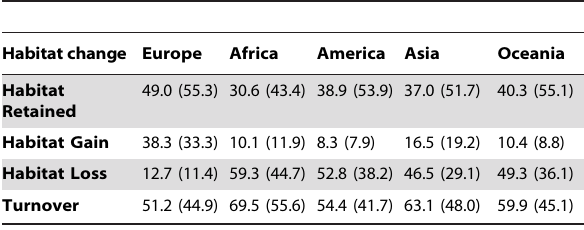
Table 2. Predicted changes (%) of potential suitable habitat of P. clarkii among five continents.